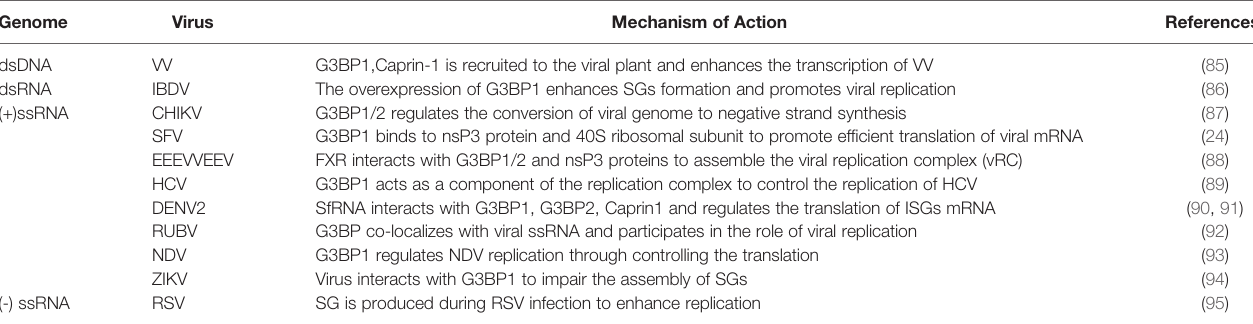
TABLE 3 | G3BP promotes viral